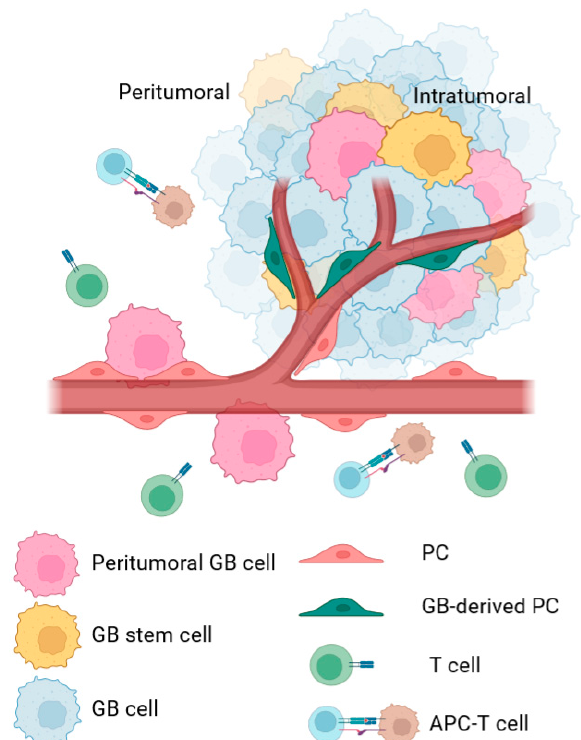
Figure 1. Schematic representation of cell type differences in peritumoral and intratumoral areas of GB cancer. In the peritumoral area, peripheral GB cells interact with peritumoral PCs from pre- existent blood vessels and promote several changes in their phenotype. These changes facilitate processes such as co-optation or peritumoral immune evasion, which help with tumor survival, tumor cell infiltration, and tumor spreading in the brain. In the intratumoral area, most studies identify PCs as cells derived from the tumor, which includes not only regular PCs, but also PCs derived from GSC. These PCs are defined to help in angiogenesis or immune evasion of the tumor. In both areas, the cellular changes are intended to promote tumor survival and